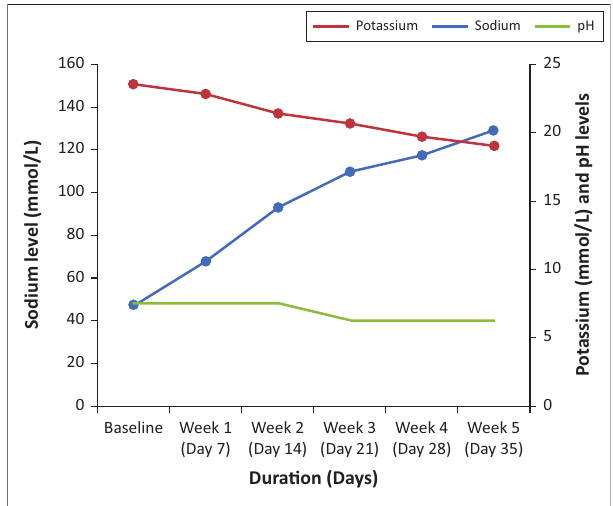
FIGURE 1: Potassium levels demonstrated an increasing trend, while sodium levels and pH demonstrated a decreasing trend as storage period